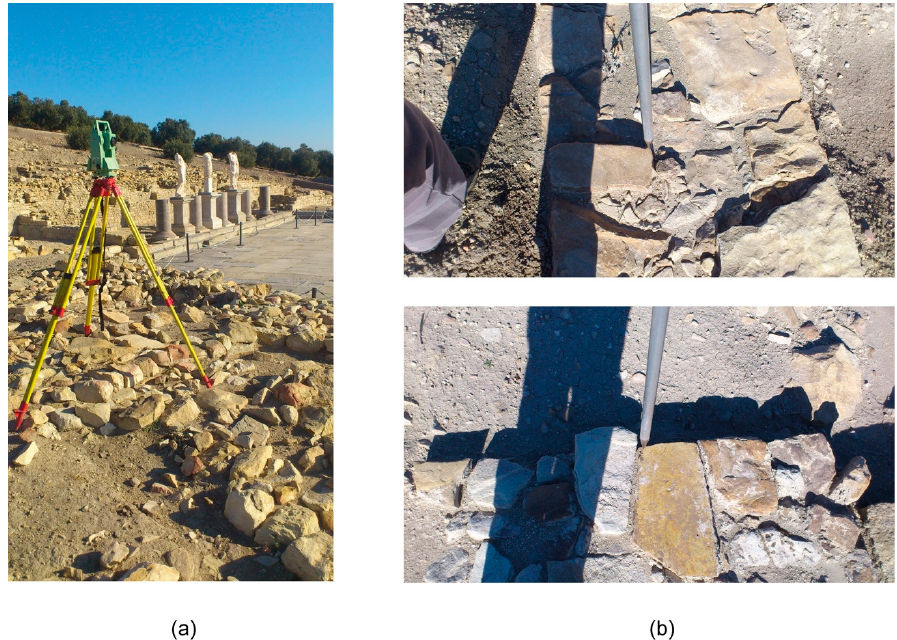
Figure 3. Scheme of unmanned aerial vehicle (UAV) flights and processing.